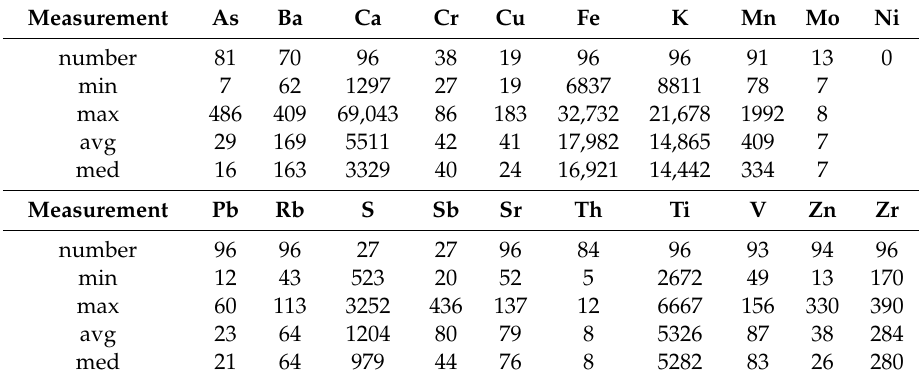
Table 3. Elementary statistics for Ah horizon observations, pXRF measurements (in mg / kg).